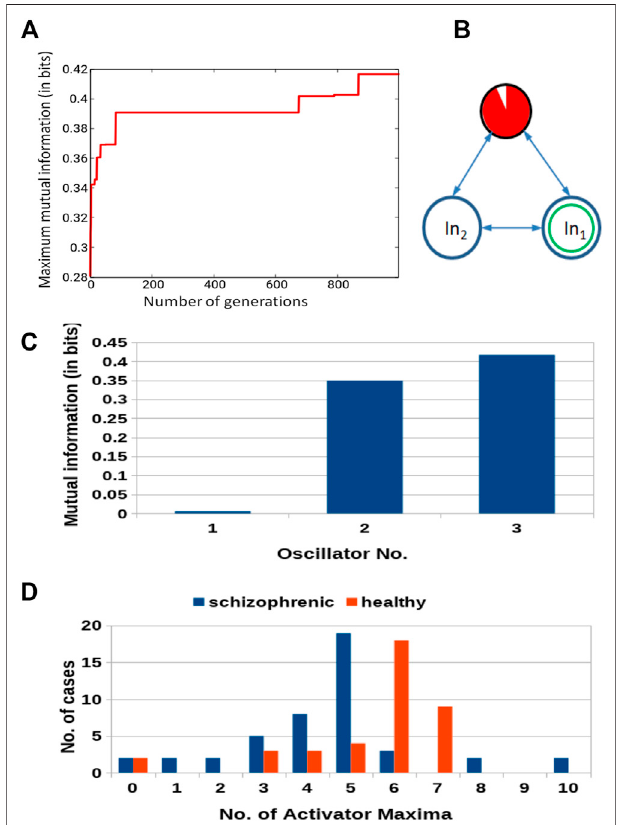
FIGURE 5 | Results for 3-oscillator network (cf. Figure 2A ): (A) The progress of optimization; the Fitness as a function of generation number. (B) The structure of the optimized network. The disk within a black circle is the normal oscillator. The ratio between the surface of the red shaded part and the disk surface represents the ratio between t j illum and t max . In 1 and In 2 mark inputs for p 1 and p 2 . The disk with the green circle inside is the output oscillator. (C) The mutual information I ( G ; O j ) for j ∈ {1,2,3}. The mutual information has the maximum at the oscillator # 3. (D) The distribution of the numbersofcasesforwhichagivennumberofactivatormaximawasobserved on oscillator # 3. Colors indicate records representing schizophrenic and healthy patients.